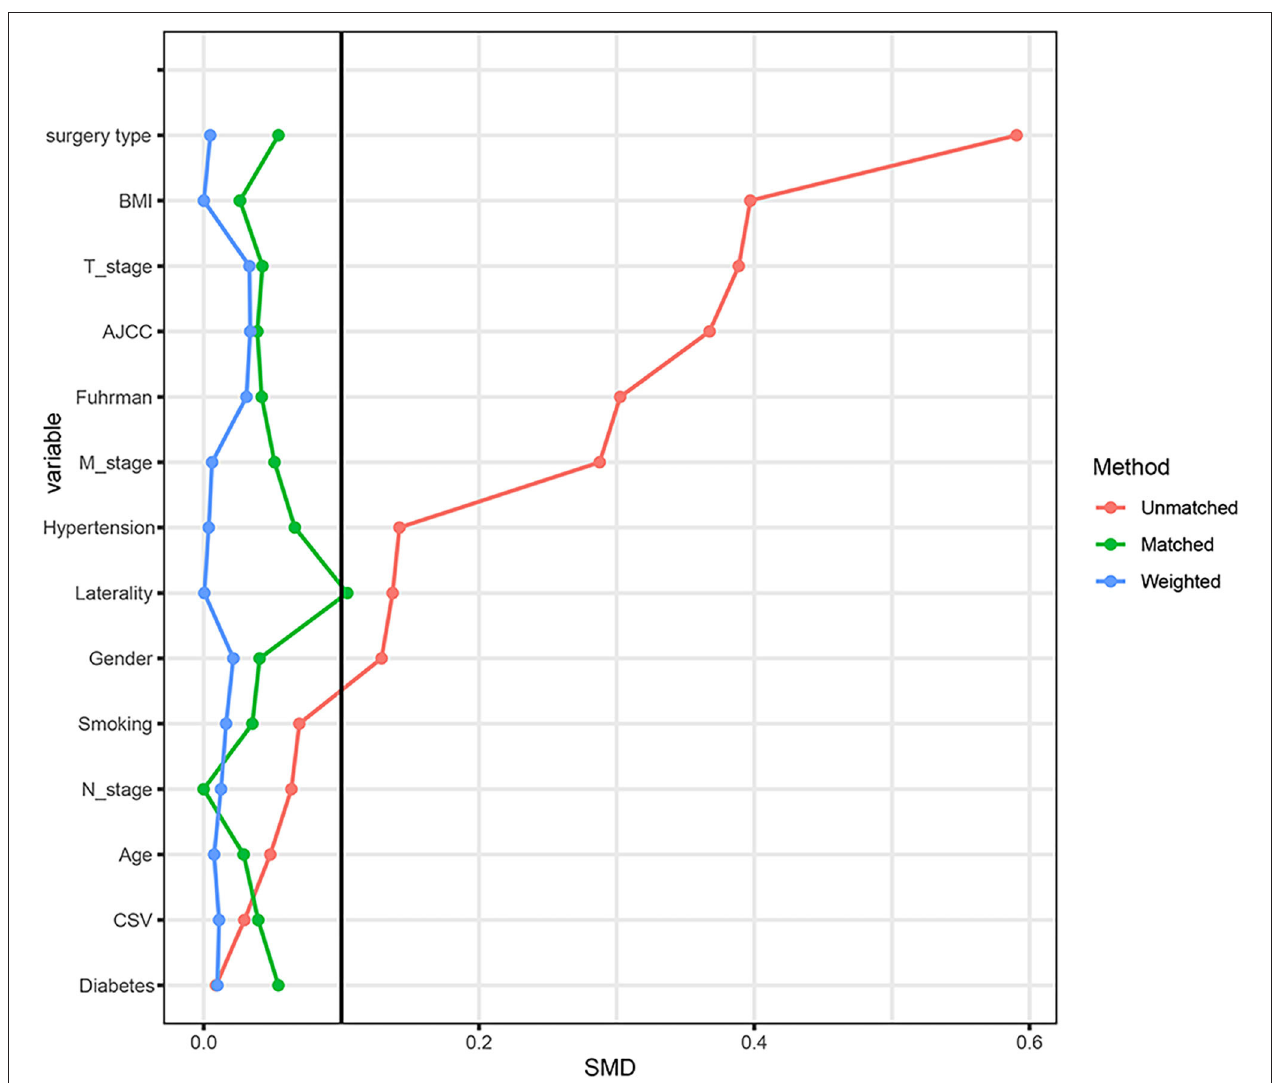
FIGURE 4 | The standardized mean difference (SMD) results of different variables after PSM. PSM, propensity score